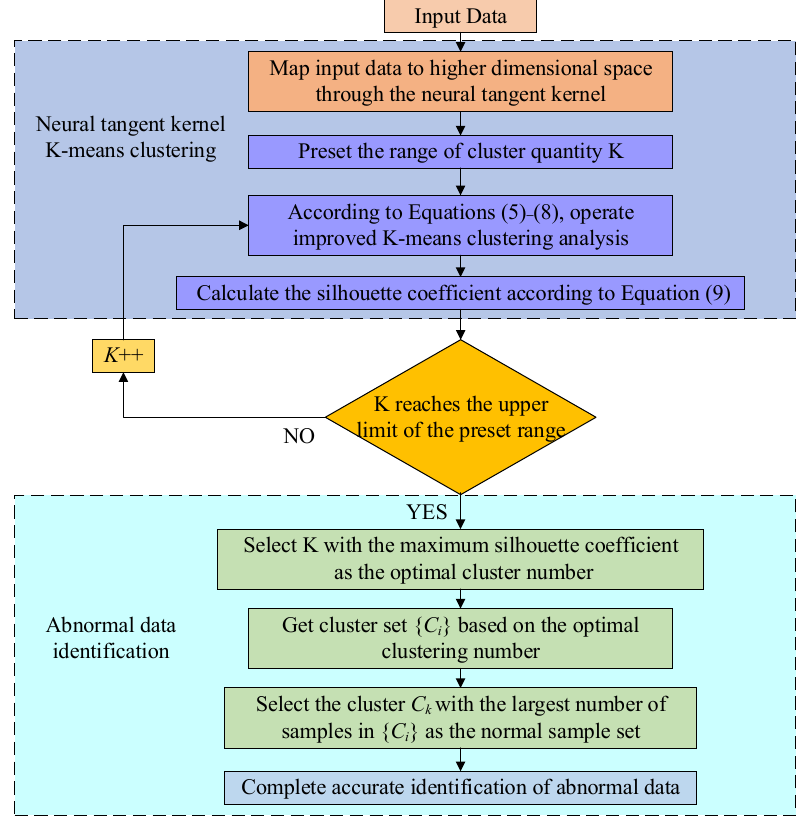
Figure 1. Schematic diagram of intelligent identification process of outliers based on neural tangent kernel K ‐ means clustering.